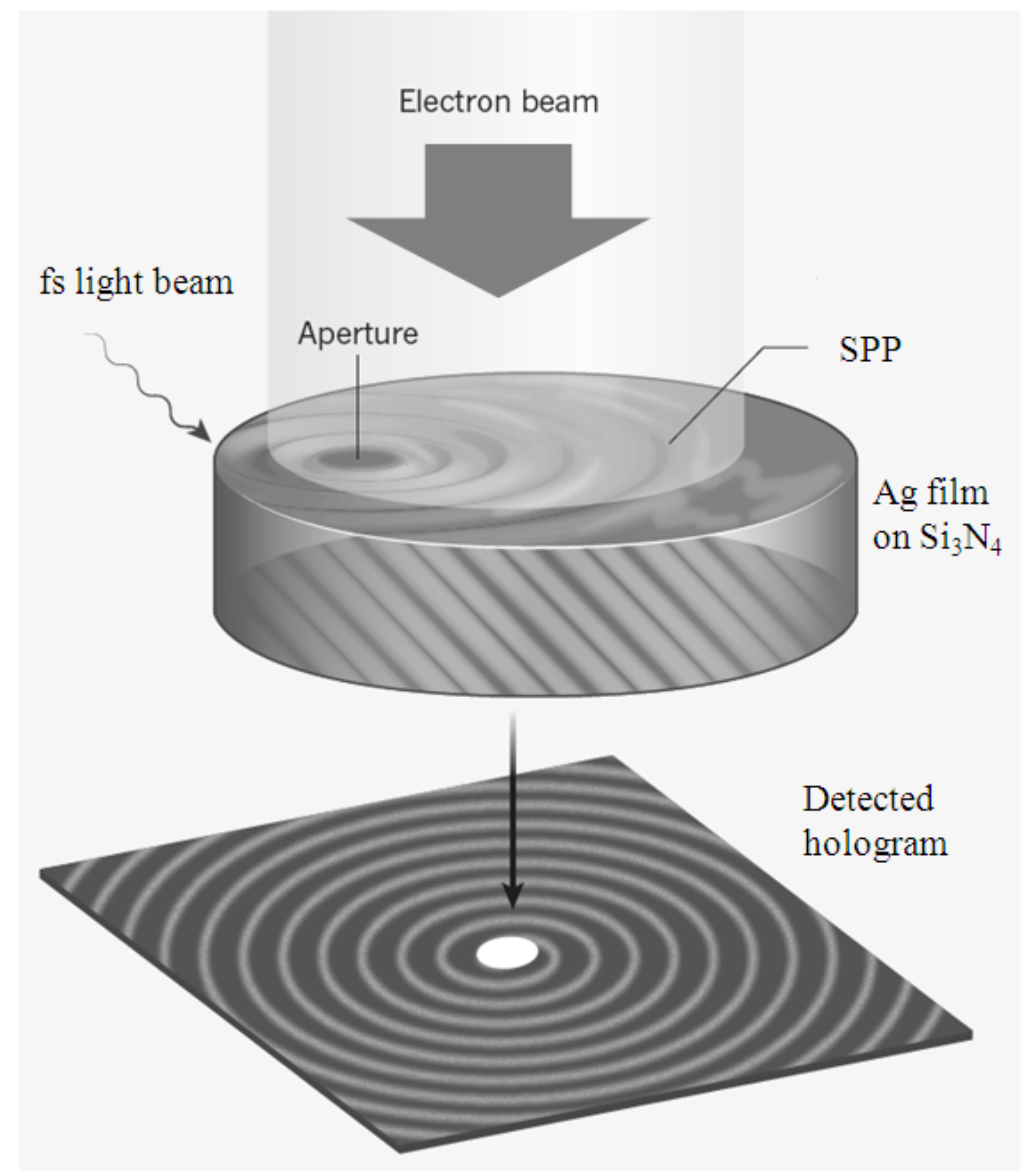
Figure 7. Ultrafast mapping of electron–light interference: In the experiment in [60], light irradiates a metal film that contains an aperture, to produce surface plasmon polaritons (SPPs). A different light–field pattern, which is illustrated by stripes, is produced on the other side of the film. When an electron beam passes through the specimen, it subsequently interacts with the fields on both sides, producing a spiral interference pattern. This pattern encodes the relative phases of the light fields at each position on the film, and therefore contains holographic information (adapted from [61] with minor changes).